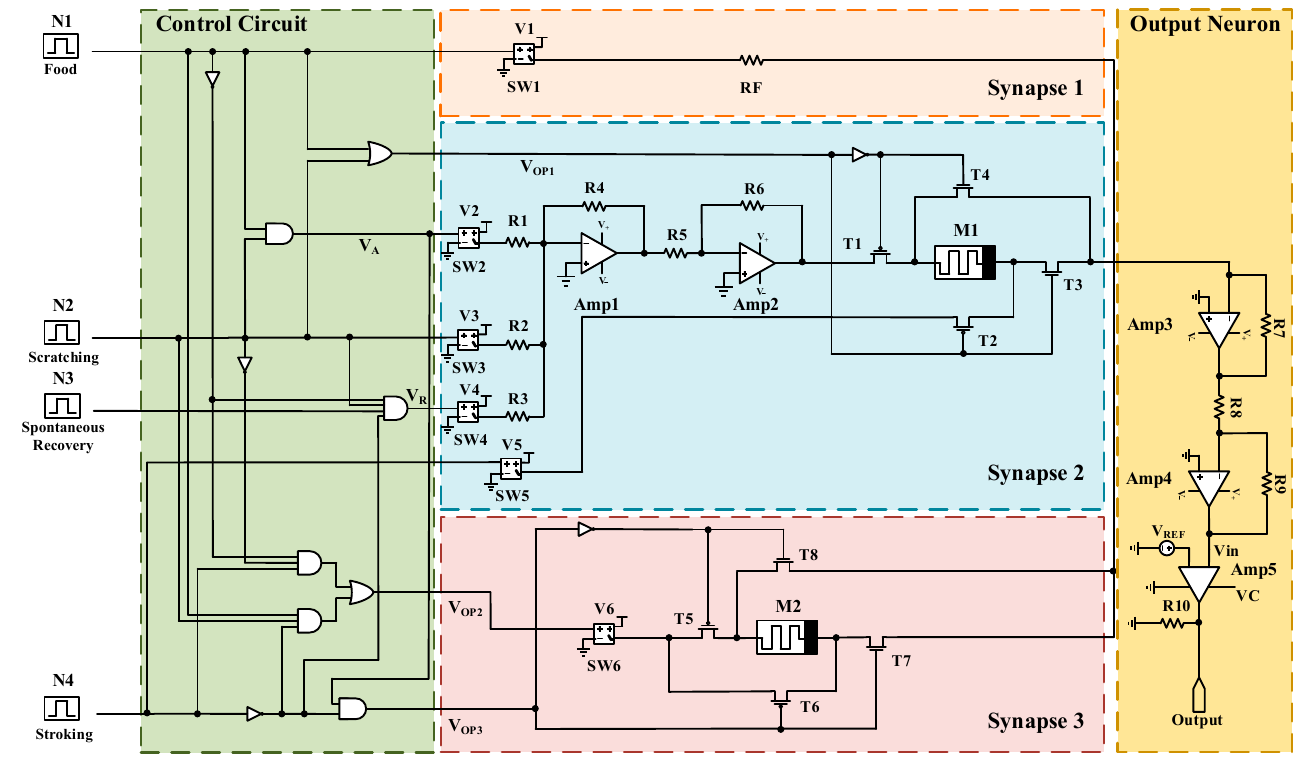
Figure 8. The schematic view of the proposed circuit for Pavlovian conditional reflex. Table 3 provides the critical description of each simulation framework. It is worth noting that ”1” and ”0” binary digits represent activated and deactivated states of signals, respectively. Table 3. The status of electrical components and signals during simulation.